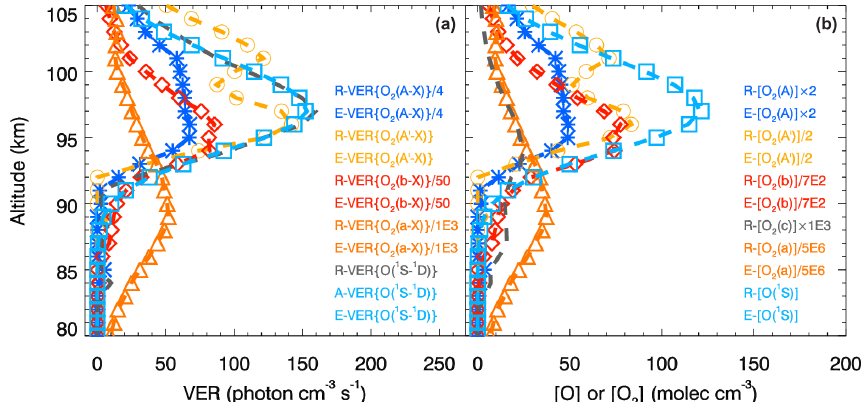
Figure 3. The retrieved VER (R-VER) profiles obtained during the ETON campaign (see Sect. 2) and the evaluated VER (E-VER) profiles obtained using the MAC model involving O 2 (A) and O 2 (A (cid:48) ) are shown in panel (a) by the dashed lines and symbols. Calculations carried out using the MAC model involving O 2 (A) and O 2 (A (cid:48) ) are verified visually by comparing the R-VER and E-VER profiles. Concentrations of various chemical species were retrieved on the basis of the corresponding R-VER profiles and all relevant processes of the MAC model; these concentrations are marked with a character R and shown in panel (b) by the dashed lines. The respective transition probabilities are only used to evaluate concentrations marked with a character E as well as E-VER profiles. Again, the evaluated concentrations are shown with the use of symbols as done for E-VER profiles. Two corresponding profiles (R-VER and E-VER as well as the retrieved and evaluated concentrations) seem to be in perfect agreement with each other by sight. This implies that all calculations carried out with the MAC model are consistent with each other and the results are coherent with measurements. The corresponding consistency tests are described in Sect. A2.4, A3.3 and A4.2. Note that the conversion between profile values of VER and concentrations is based on trivial but required calculations provided in Sect. A2.1, A2.2, A2.3, A3.2 and A4.1. The abbreviations indicating emissions are explained in Table 1, and the sequence of the retrieval steps is provided in Table 12. Values of temperature, [N 2 ] and [O 2 ] were obtained by using the NRLMSISE-00 model (see Sect. 2) for the time and place of the P229H rocket.